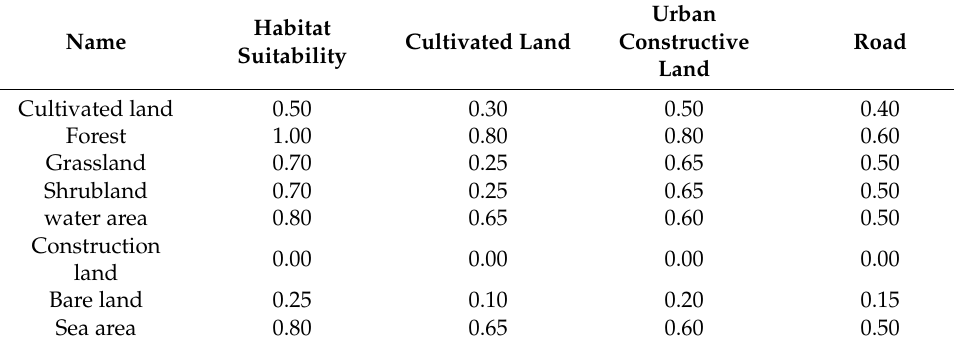
Table 2. Sensitivity of land-use types to the threat